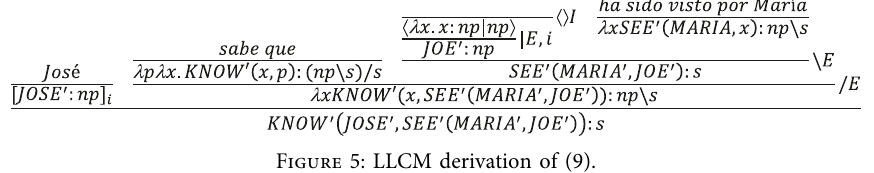
Figure 5: LLCM derivation of (9).